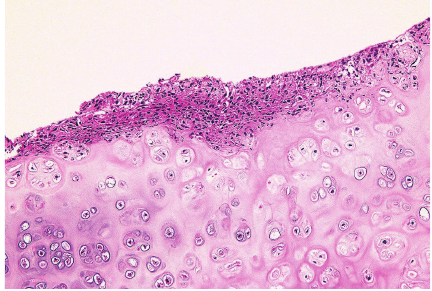
Figure 4: Photomicrograph of the colonic mucosal biopsy in a 36- year-old man with RP. There are crypt abscesses with infiltration of neutrophils and eosinophils. (Hematoxylin and eosin stain, × 100). RP, relapsing